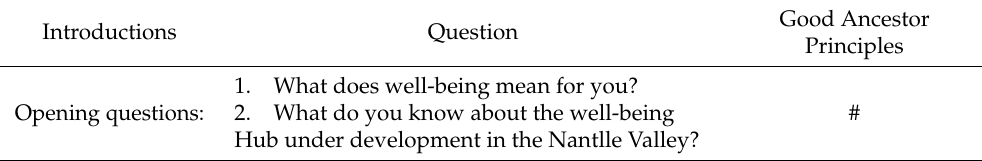
Table 4. Future generations group